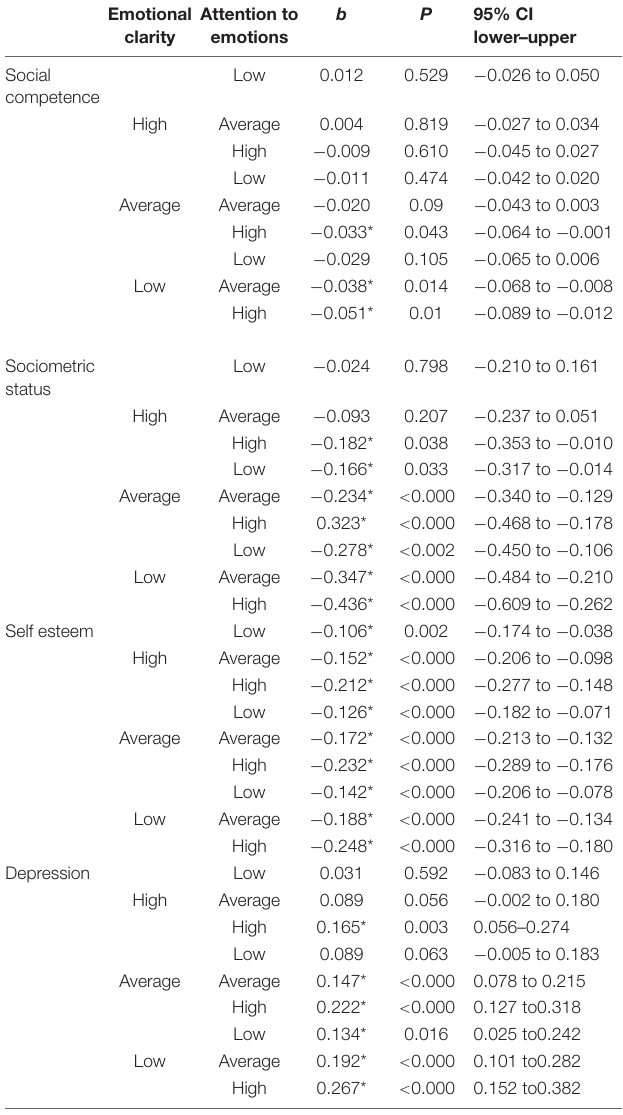
TABLE 4 | Conditional effects of SA at different levels of attention to emotions and emotional clarity. Emotional Attention to clarity